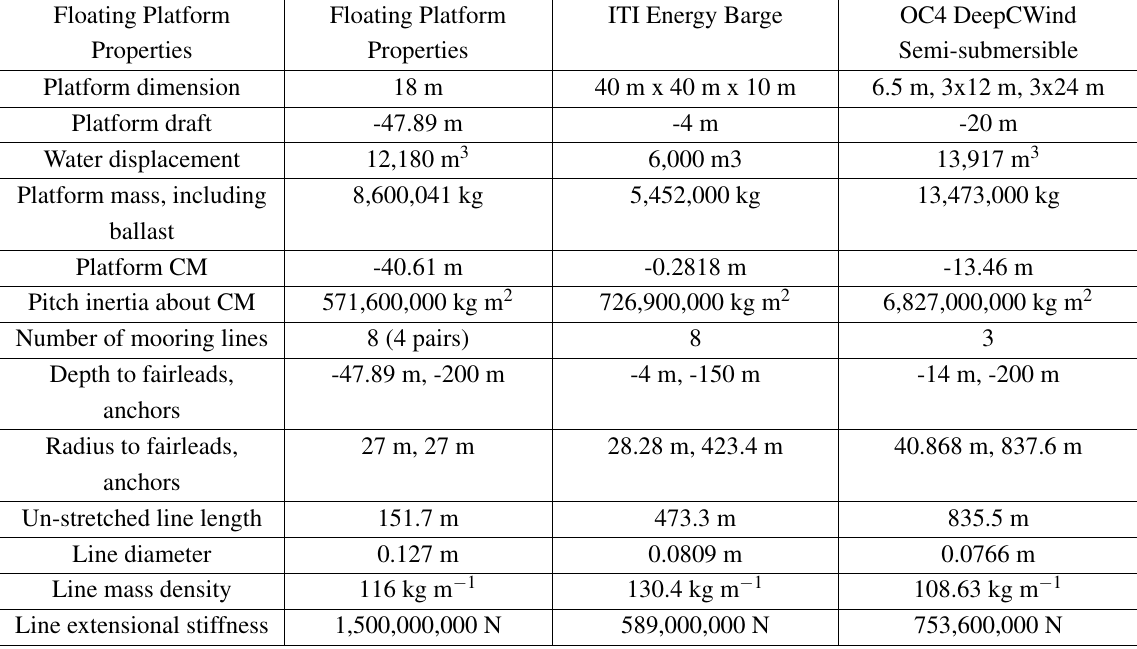
Table 2. NREL TLP, barge (Jonkman, Butterfield, Musial, & Scott, 2009), and semi-submersible platform properties (MATLAB and Statistics Toolbox Release,